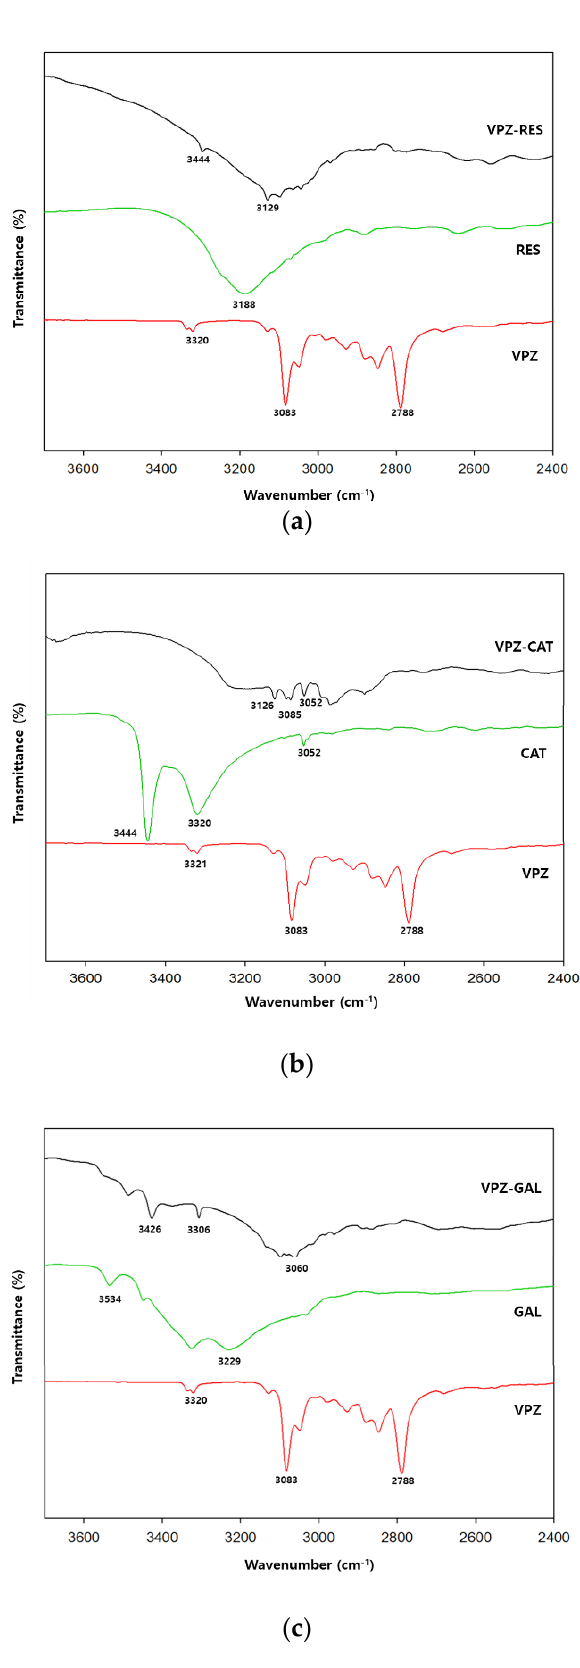
Figure 4. ATR-FTIR spectra of ( a ) VPZ-RES, ( b ) VPZ-CAT, ( c ) VPZ-GAL, and their respective components in the region of 3700–2400 cm − 1.